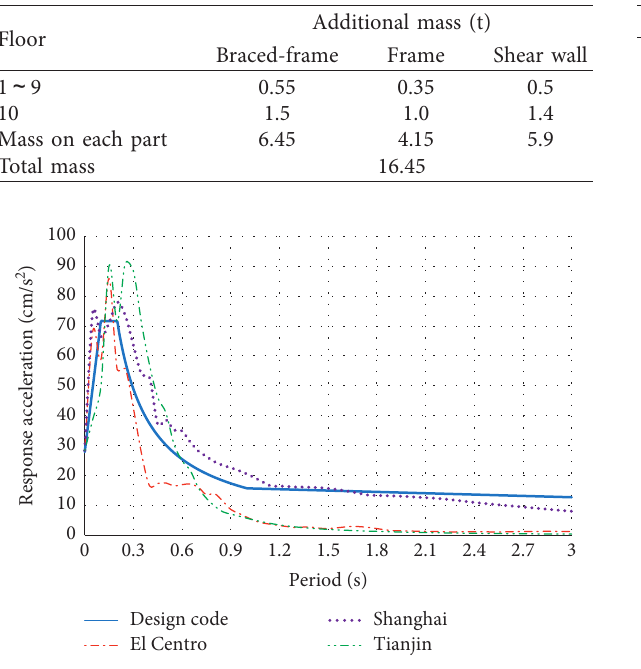
Figure 13: Comparison between the response spectrum of selected ground motions and design